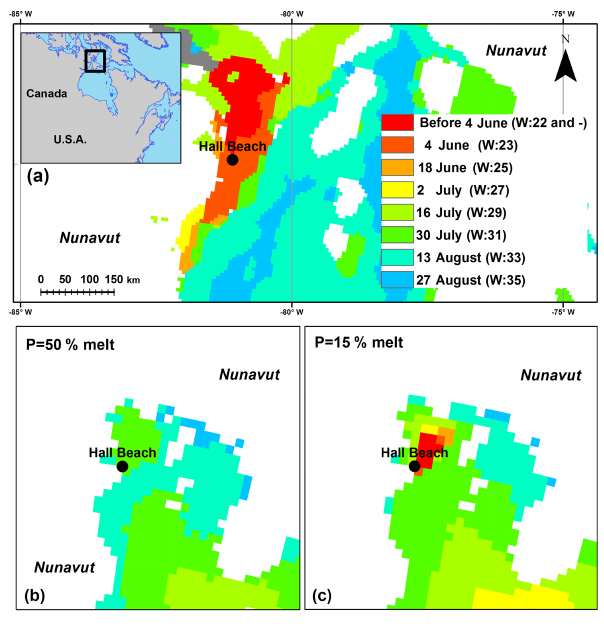
Figure 10. Comparison of probable melt weeks for the coastal com- munity of Hall Beach in Foxe Basin with the CIS melt weeks (a) and two IcePAC melt week scenarios for 50% (b) and 15% (c) probabil- ities. No data appear north of the IcePAC outputs since Hall Beach is located at the upper limit of the IcePAC model test